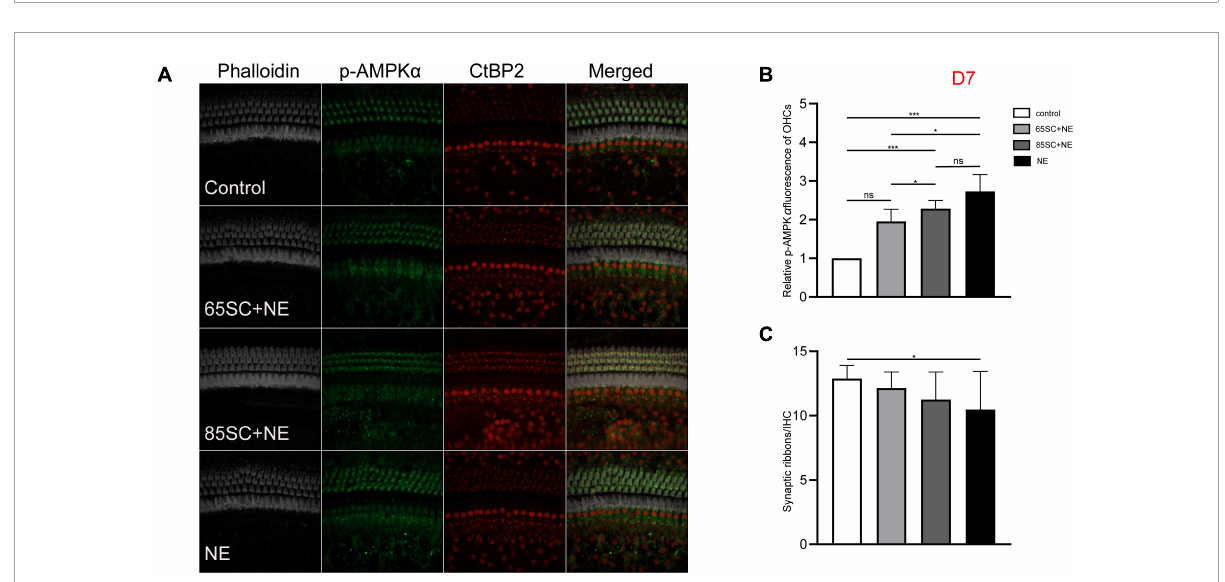
FIGURE7 The p-AMPK α fluorescence intensity decreased and the number of ribbon synapses gradually recovered in the noise exposed groups at D7. (A) The p-AMPK α fluorescence intensity and the number of synapses of the four groups at D7. (B) There was no significant difference in p-AMPK α fluorescence intensity between the 65SC+NE group and the control group ( p > 0.05), p-AMPK α fluorescence intensity of the NE and 85SC+NE groups was higher than of the control group ( p < 0.001), the NE group showed greater p-AMPK α fluorescence intensity than the 65SC+NE group ( p < 0.05). (C) Among the four groups, the NE group had the least number of ribbon synapses ( p < 0.05). * p < 0.05, *** p < 0.001.